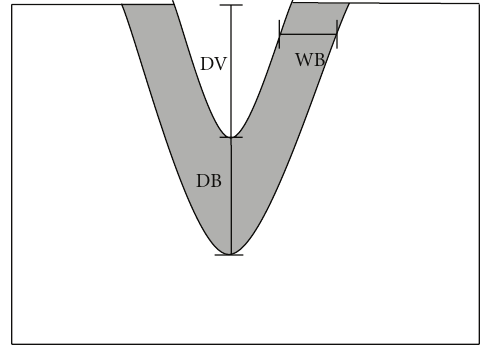
Figure 2: The measurements of the histologically a ff ected borders. Depth of vaporization: DV. Depth of vertically a ff ected border: DB. Width of horizontally a ff ected border: